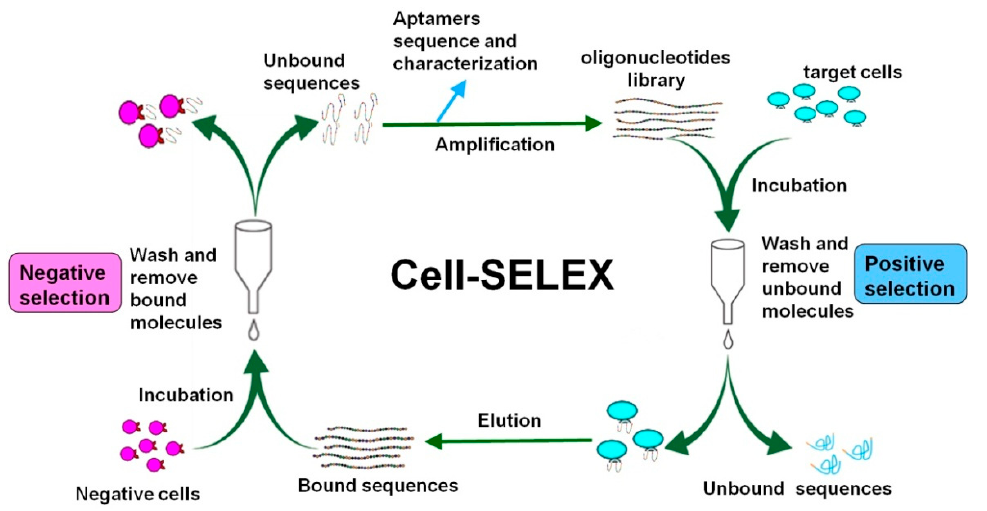
Figure 1. Schematic representation of aptamer selection using the cell-SELEX (systematic evolution of ligands by exponential enrichment) strategy.